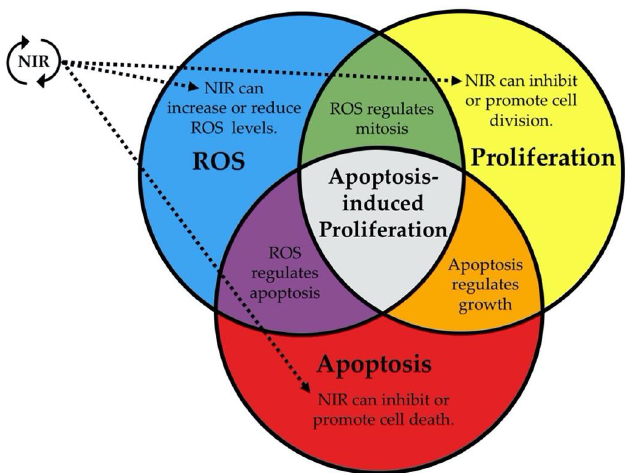
Figure 2. Relationships between key concepts. Overlap between reactive oxygen species (ROS) signaling, apoptosis, and cell proliferation (Venn diagram), overlaid with the known effects from non-ionizing radiation (NIR) exposure (dotted lines).